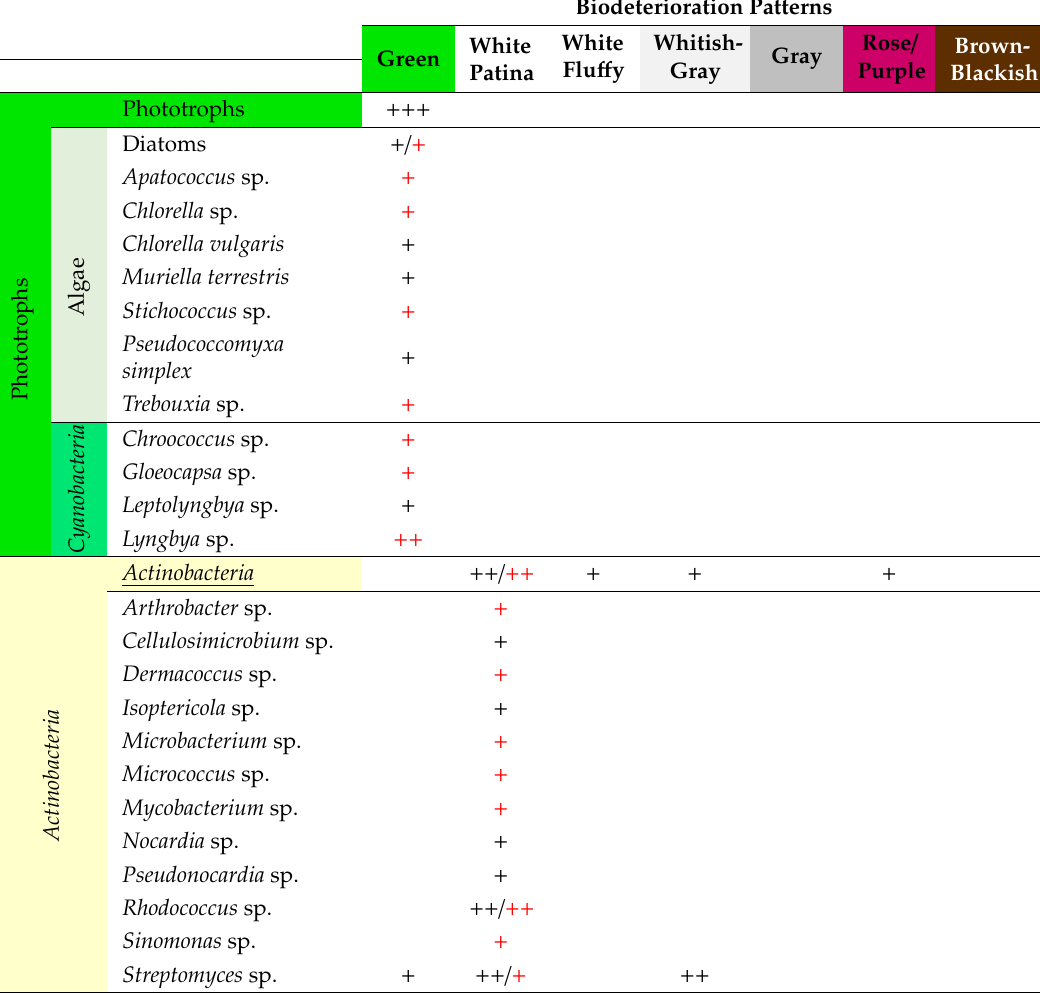
Table 1. Phototrophic and bacterial deteriogens associated to biodeterioration patterns found in Italian [25,26,28,32,37–48,80–82] and South Korean tombs [33,34,55–60,62,73,83–87].